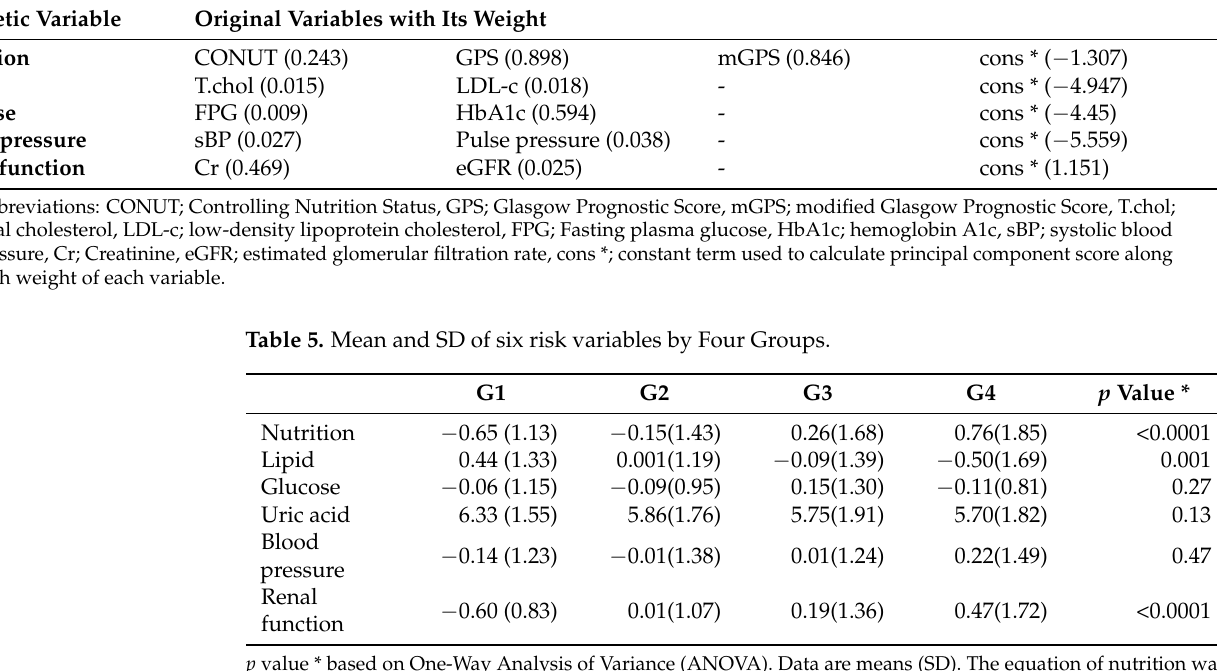
Table 4. Comportments of Synthetic variable with weights.